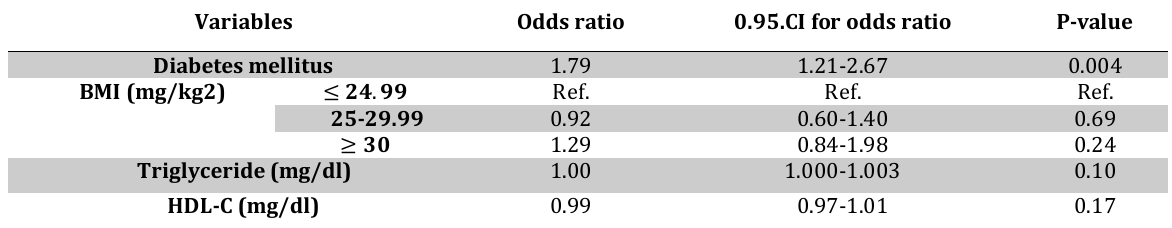
Table 2 : Association between CVD risk factors and COVID-19 in MASHAD study population